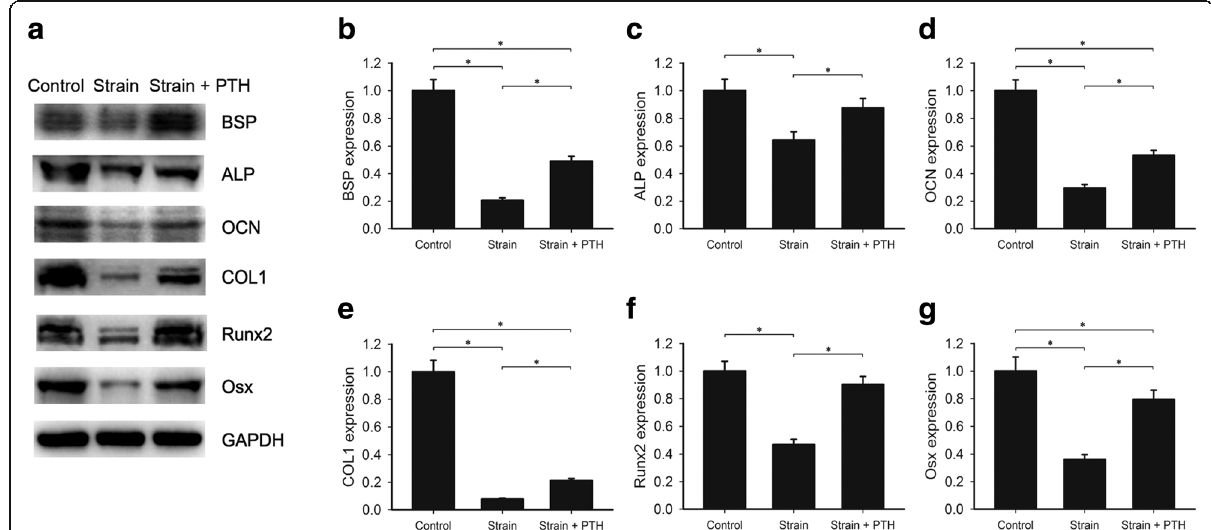
Fig. 7 Intermittent PTH attenuated cementogenesis-related gene expression inhibition that was induced by mechanical strain. a Western blot analysis of BSP, ALP, OCN, COL1, Runx2 and Osx levels in cells of the control group, the strain group and the strain + PTH group that was treated with mechanical strain and intermittent PTH (also shown in Additional file 4: Figure S3). Except the control group, other two groups were both treated with 18 h mechanical strain, while the control group was placed in the bending box without mechanical strain. Then, the control group and the strain group were exposed to 3 cycles of vehicle treatment. Each cycle comprises 6 h vehicle medium and 18 h fresh medium. Mean- while, the strain + PTH group were exposed to 3 cycles of intermittent PTH administration. Each cycle comprises 6 h PTH (50 ng/ml) medium and 18 h fresh medium. Results were representative of 3 experiments. b - g Densitometry of bands was performed and normalized to GAPDH. The control group was set to 1. Bars represent means ± SD of triplicate measurements. * p <